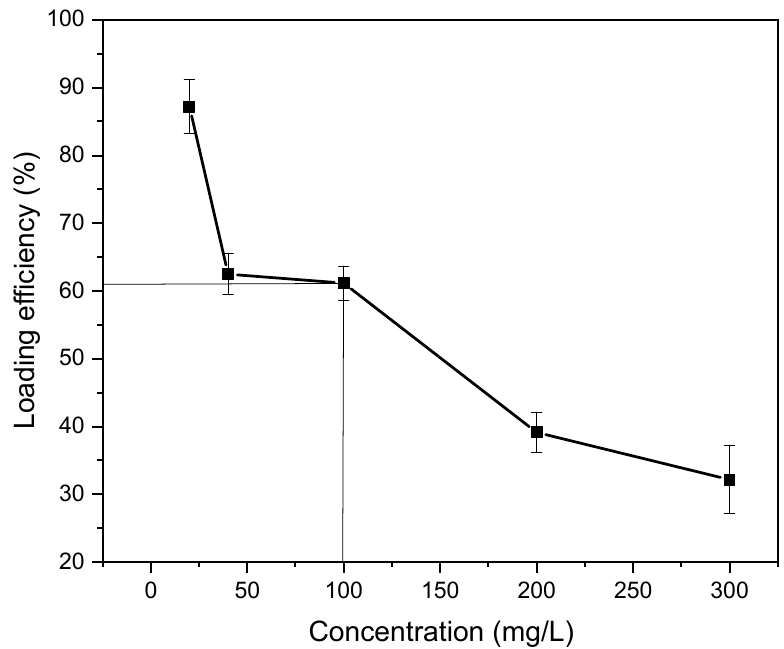
Figure 11. Optimum drug loading efficiency determination.